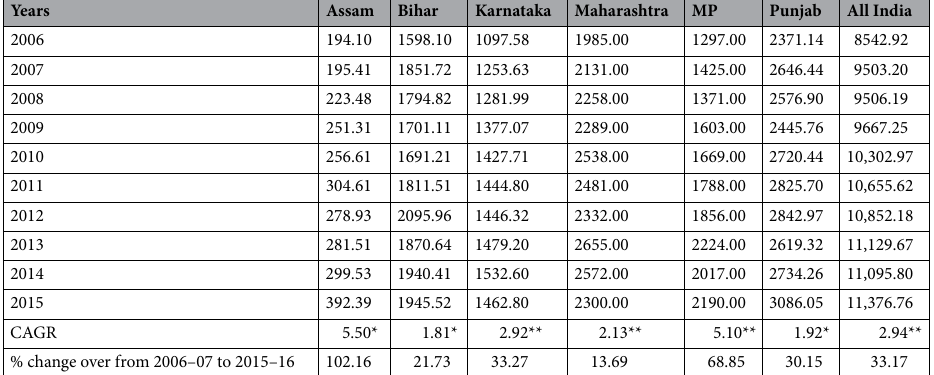
Table 2. Trends in all India urea production, import, consumption and prices. (000 mt). Source: Authors’ estimates using indiastat.com data. ** & *denotes significance level at 1 and 5%, respectively. Figures in parentheses indicate Metric Tonnes